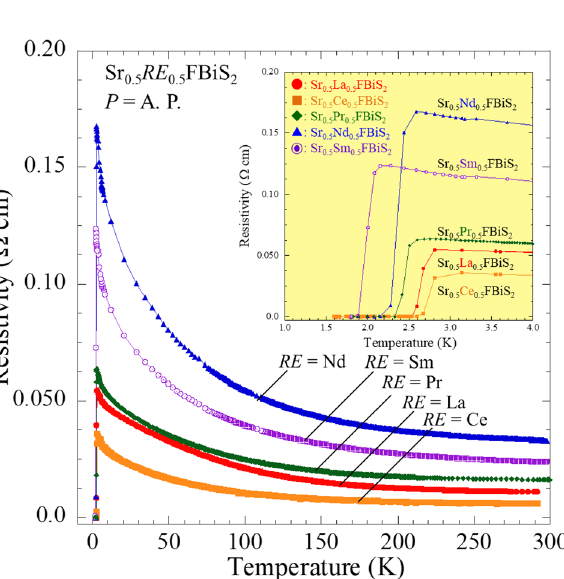
Table 1. Actual composition (mol%) from the EDX analysis against the nominal composition (mol%). Fluorine amount is regarded as 1.